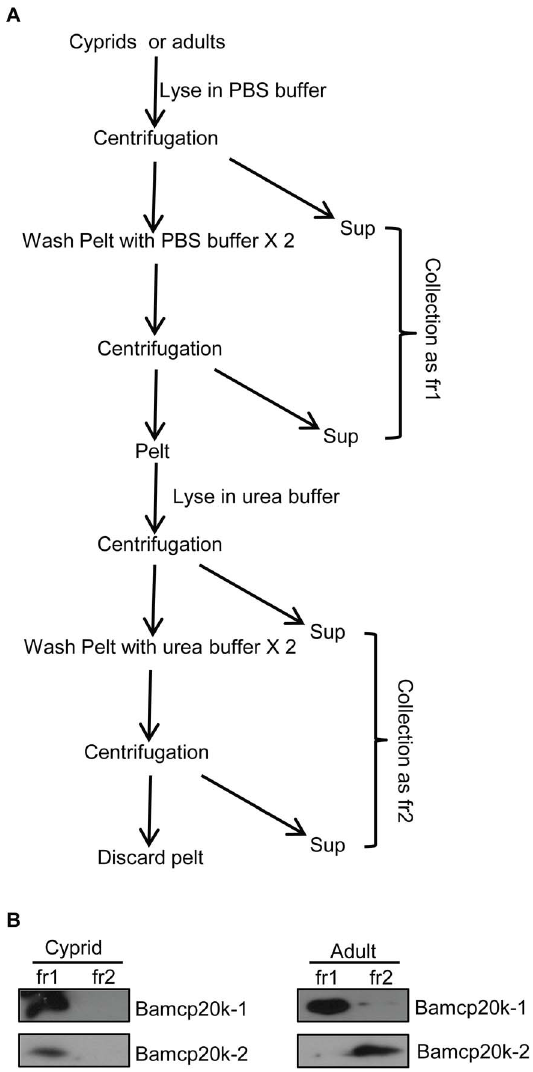
Figure 5. Adult Bamcp20k-2 was insoluble in PBS. (A) PBS and urea soluble fractions were prepared from cyprids and adults. Cyprids or adults were extracted in PBS. After centrifugation, the supernatant was collected and the pellet was washed with the same buffer. The supernatant from each centrifugation was collected and labeled as fr1. The pellet from the final centrifugation was sequentially extracted in urea buffer. After a series of successive centrifugations mentioned above, the supernatant were collected and labeled as fr2. Fr: fraction; sup: supernatant; pelt: pellet. (B) Equal proportions from each fraction were collected for Western blot with the antibodies against Bamcp20k- 1 and Bamcp20k-2. Fr: fraction.